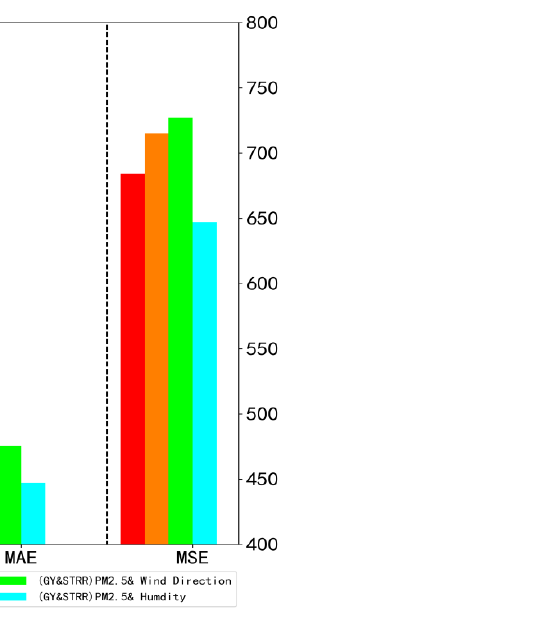
Figure 7. Two-coordinate error histogram of forecasting results based on different meteorological factors. Table 5. Analysis of forecasting results of PM2.5 in space (GY & STRR) combined with historical data of meteorological factors in different regions as input data of the network.